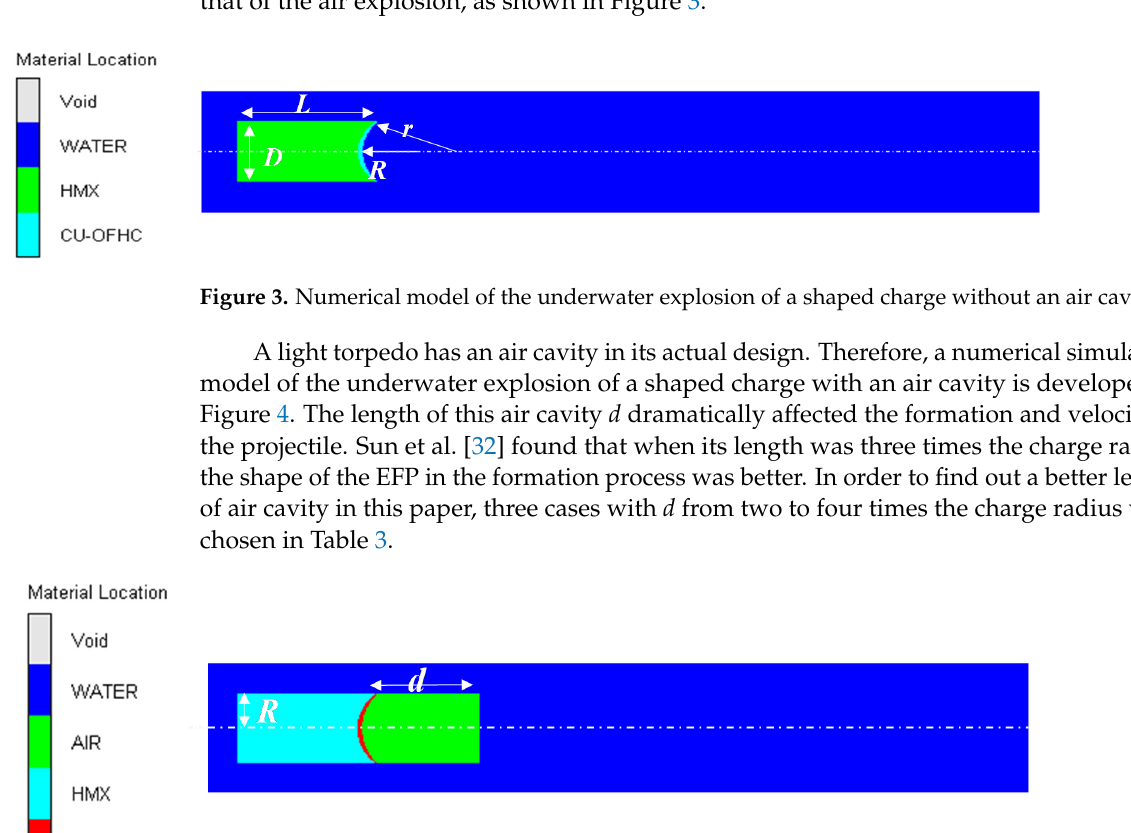
that of the air explosion, as shown in Figure 3.